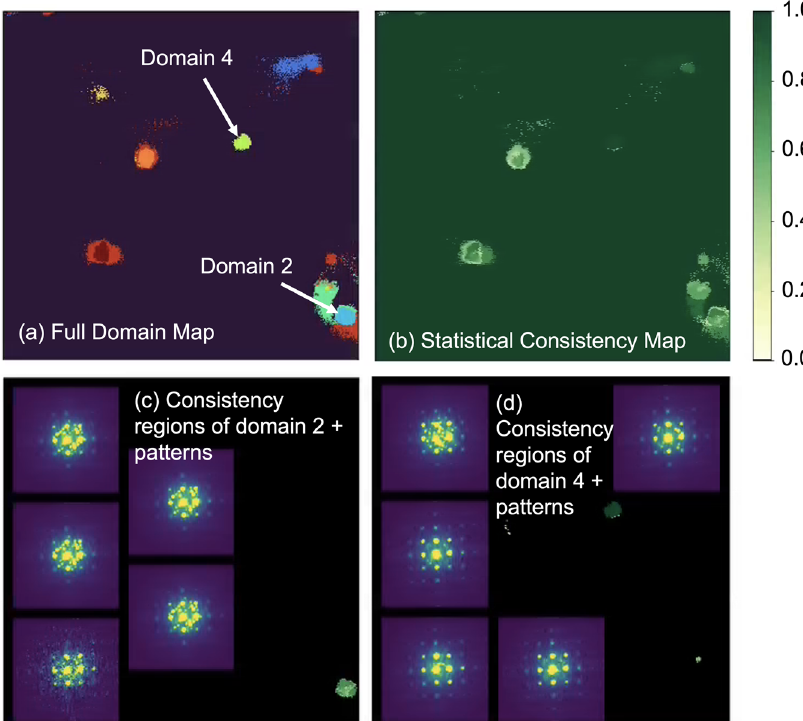
Fig. 9 Statistical con fi dence map example. a Domain mapping of precipitates on Al alloy dataset using ten components for centroid estimation. b Statistical consistency map for the domain mapping of precipitates on Al alloy dataset, comparing eight domain maps generated using 10, 12, 14, 16, 18, 20, 22 and 24 principal components for the centroid estimation. c , d Inspection of the diffraction character of identi fi ed regions of consistency for different labels (2 and 4) within the domain